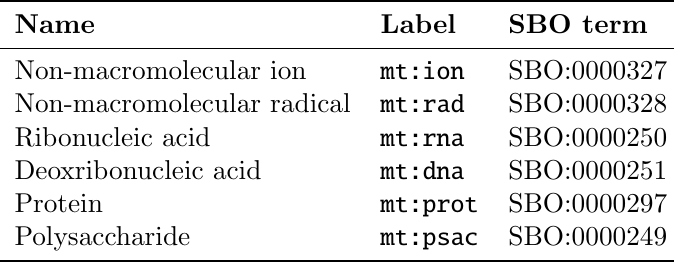
Table 2.1: A sample of values from the material types controlled vocabulary (Section 2.4.1).